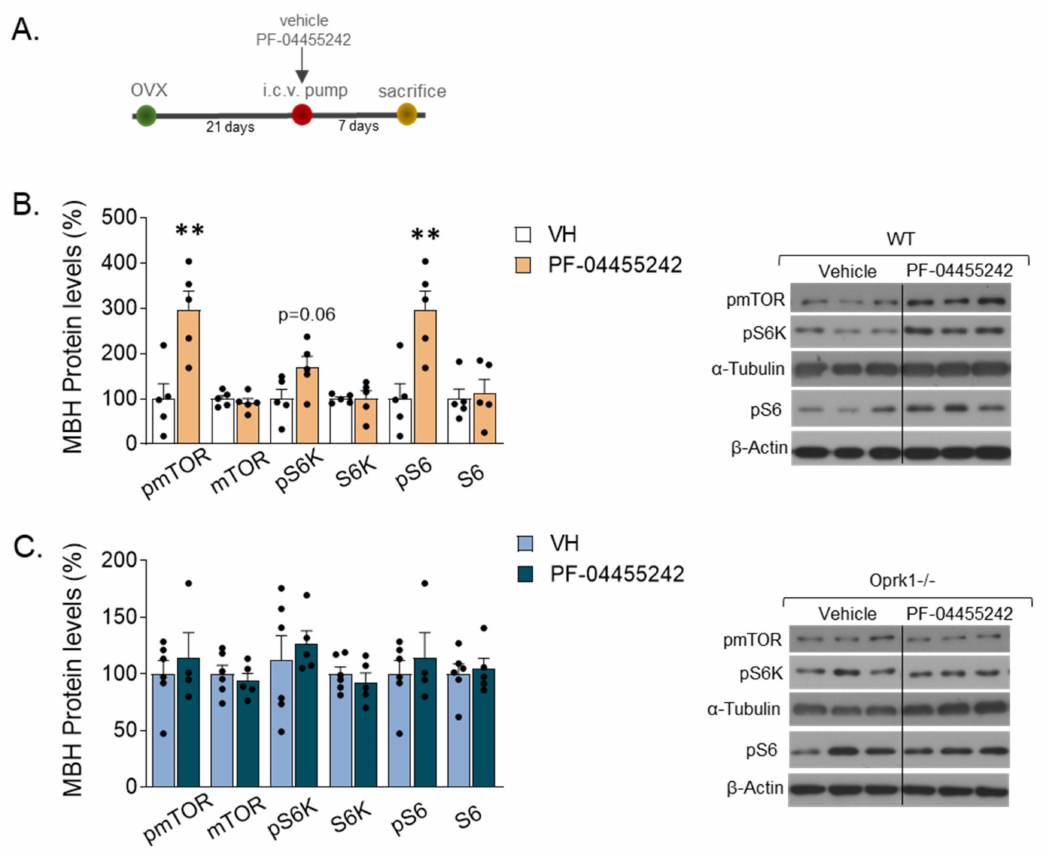
Figure 6. mTOR signaling pathway in the medio-basal hypothalamic area (MBH) of OVX mice